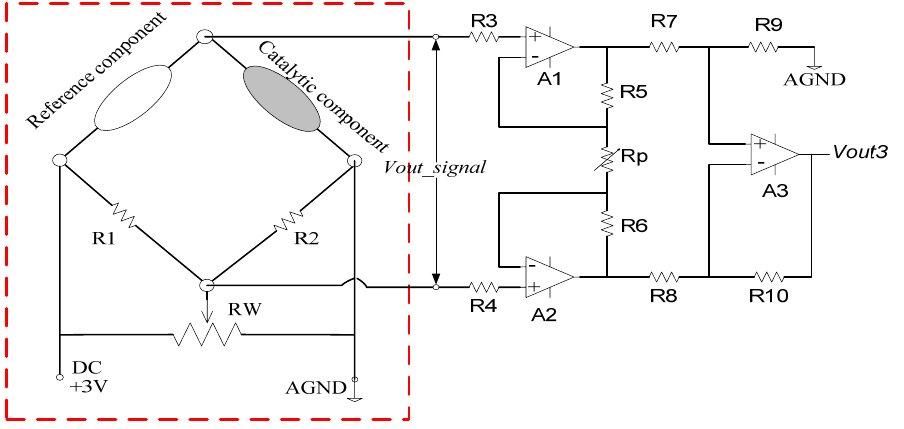
Figure 9. Measuring circuit of catalytic combustible gas sensitive